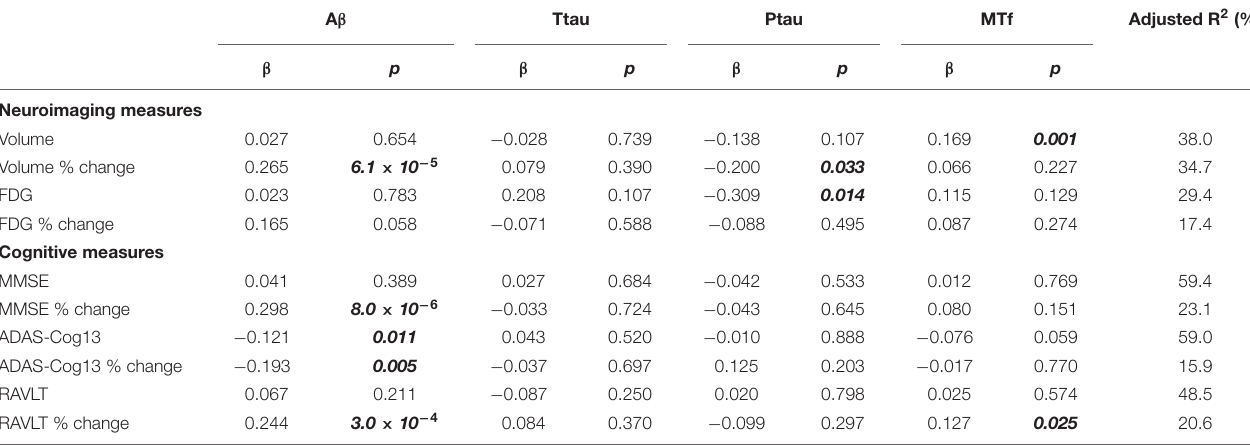
TABLE 3 | Modeling the association of CSF A β , total tau (ttau), phosphorylated tau (ptau), and melanotransferrin (MTf) with neuroimaging measures of the hippocampus and cognitive scores in the total cohort ( Supplementary Figures 1 , 2 ). A β